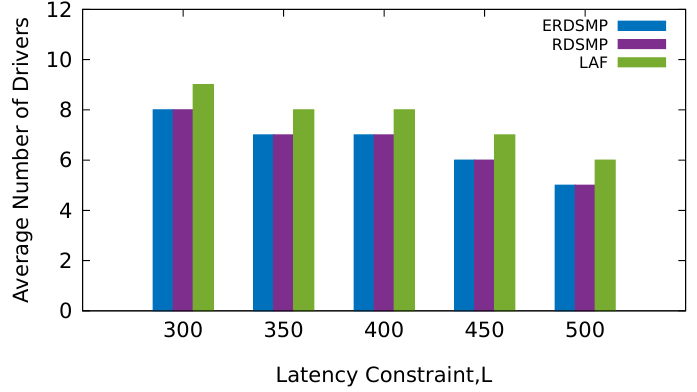
Figure 4. Average number of remote driving locations found for various latency constraints.